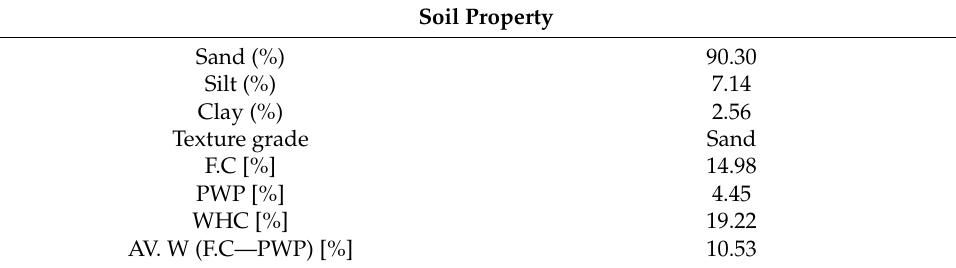
Table 1. Physiochemical characteristics of the investigated soil .